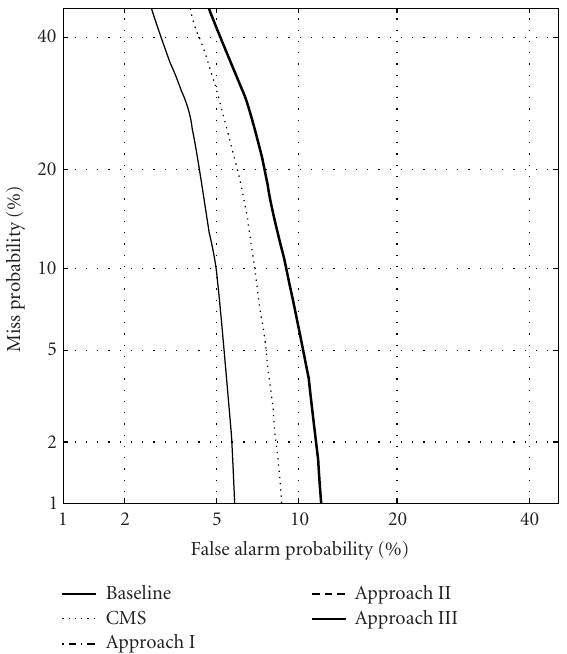
Figure 6: DET curves obtained by using the seen handset cb1 in the verification sessions. Handsets cb3 and el2 were used as the unseen handsets. The DET curves corresponding to Approaches I, II, and III are overlapped.